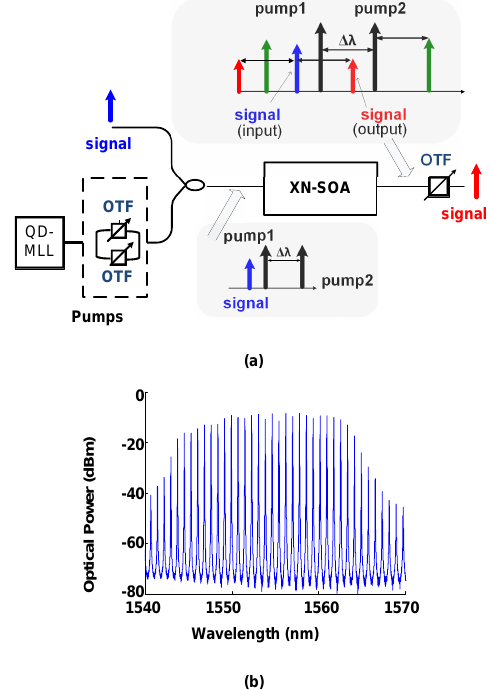
Figure 1. ( a ) Tunable wavelength converter, ( b ) quantum-dash mode-locked laser (QD-MLL)